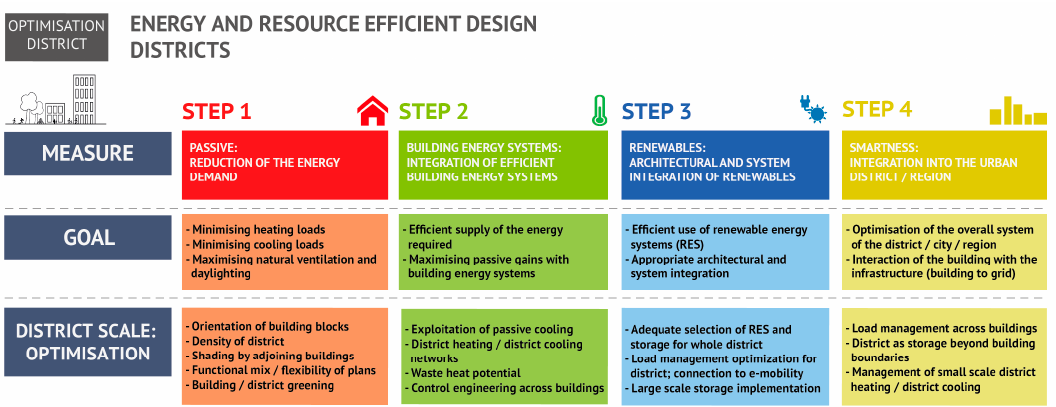
Figure 1. Methodology for resource and energy efficient design at district scale, author’s graphic adapted from [25].